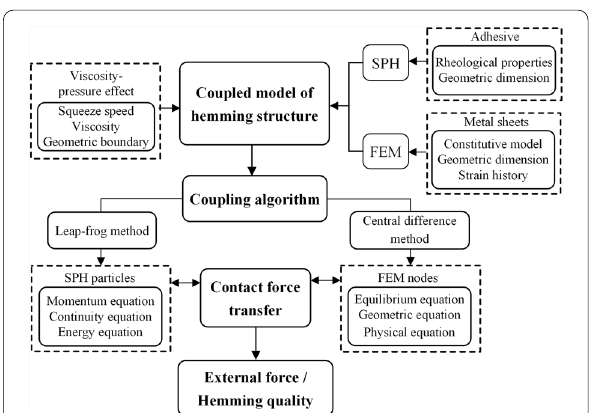
Figure 4 Flow chart of forming quality prediction based on SPH-FEM coupling